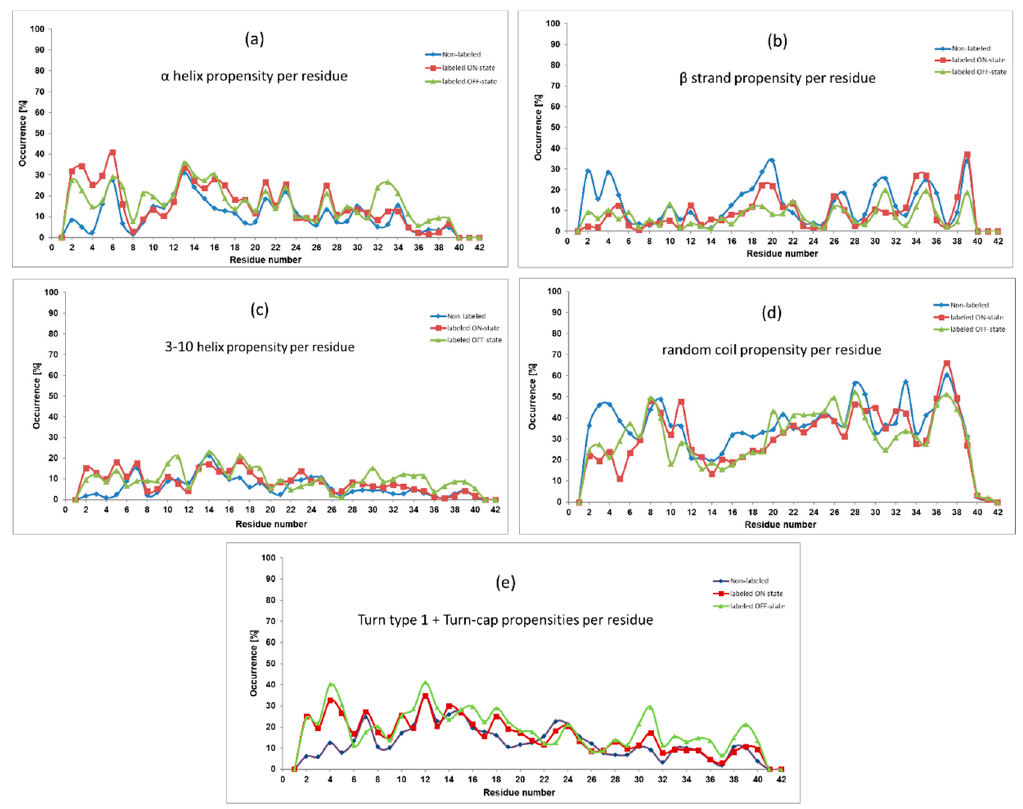
Figure 2. Occurrence (in %) of α helix (a), β strand (b), 3-10 helix (c), random coil (d) and turn types (e) secondary structure propensities for each residue.